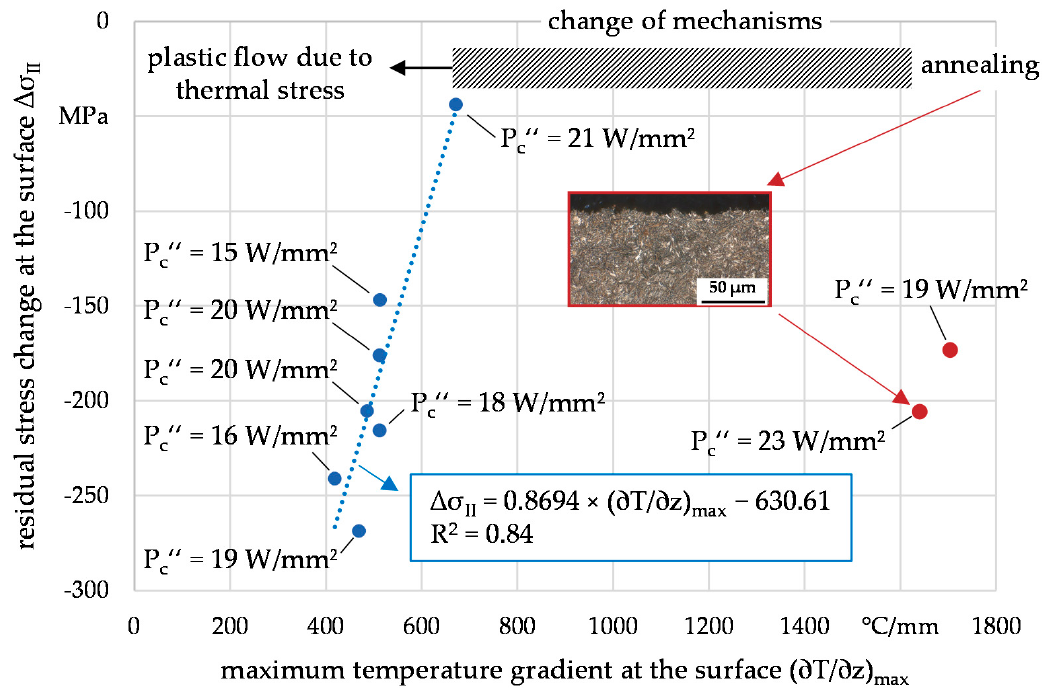
Figure 17. Change of residual stress at the surface dependent on the maximum temperature gradient at the surface in consideration of metallographic cross-section analysis (blue: no visible heat-affected zone; red: visible heat-affected zone).